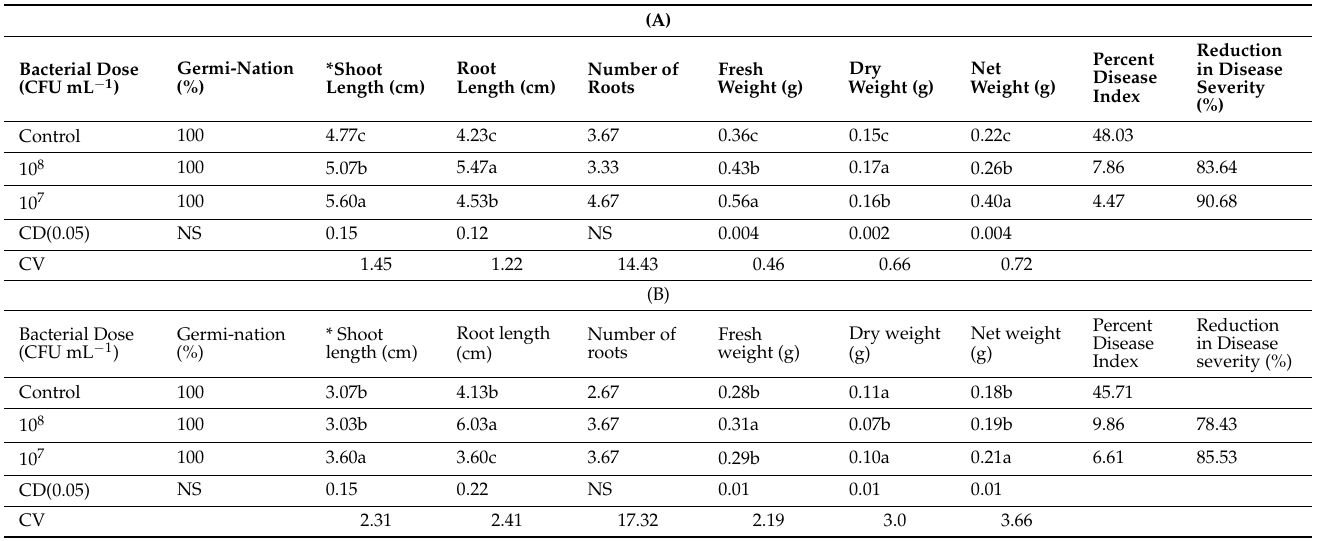
Table 4. Growth stimulant and Blast disease suppressive activity of Microbacterium testaceum B2